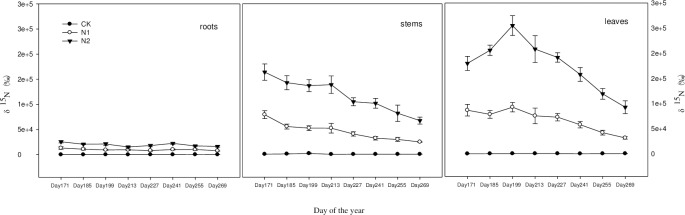
Dynamic changes in nitrogen content in the roots, stems and leaves of C. angustifolia.